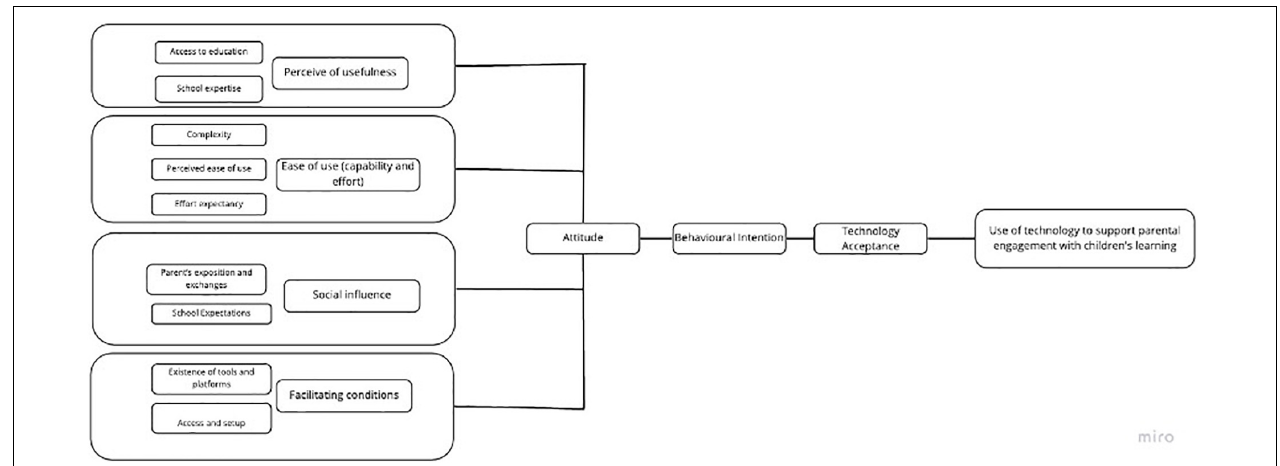
FIGURE 2 | Hypothesised model for the acceptance and use of technology to support parental engagement with children’s learning.